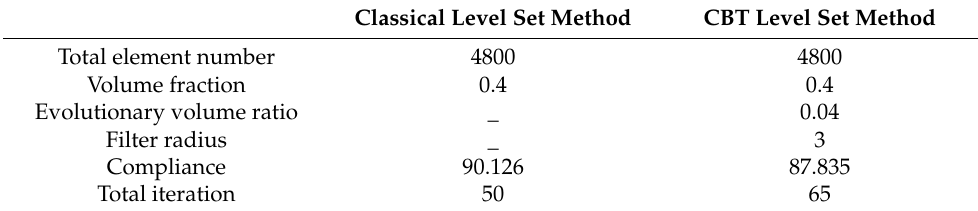
Table 5. Results for topology optimization of L-shaped beam.